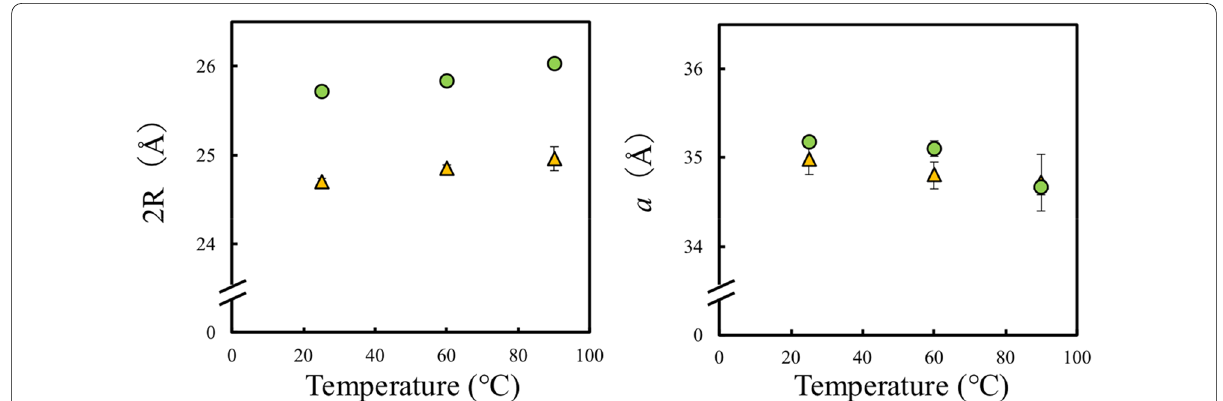
Fig. 8 Plots of the CMF diameter (2 R ) and the interfibrillar distance ( a ) obtained by the fitting calculation with the WoodSAS model, as a function of temperature: orange filled triangles and green filled circles for earlywood (EW) and latewood (LW), respectively. Error bars indicate the standard deviations in the fitting calculation with SasView